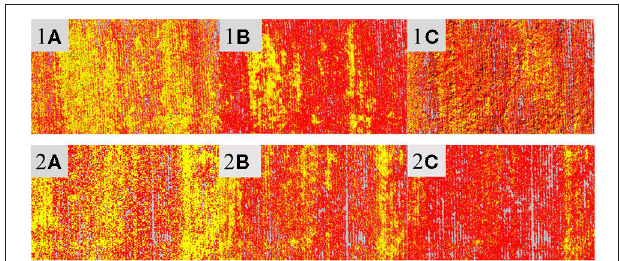
FIGURE 2 | Supervised classification method ( A : red-blue-green [RGB]; B : unfiltered multispectral; C . filtered multispectral) to distinguish between Italian ryegrass (yellow) from winter wheat (red) across imagery dates (1: February; 2: March) in 2017. Supervised classification was conducted with imagery acquired with an unmanned aerial vehicle equipped with a multispectral sensor. Red-blue-green classification accuracy did not change across imagery dates (February: 70%; March: 68%). Unfiltered multispectral classification accuracy decreased across imagery dates (February: 87%; March: 76%). Filtered multispectral classification increased across imagery dates (February: 83%; March: